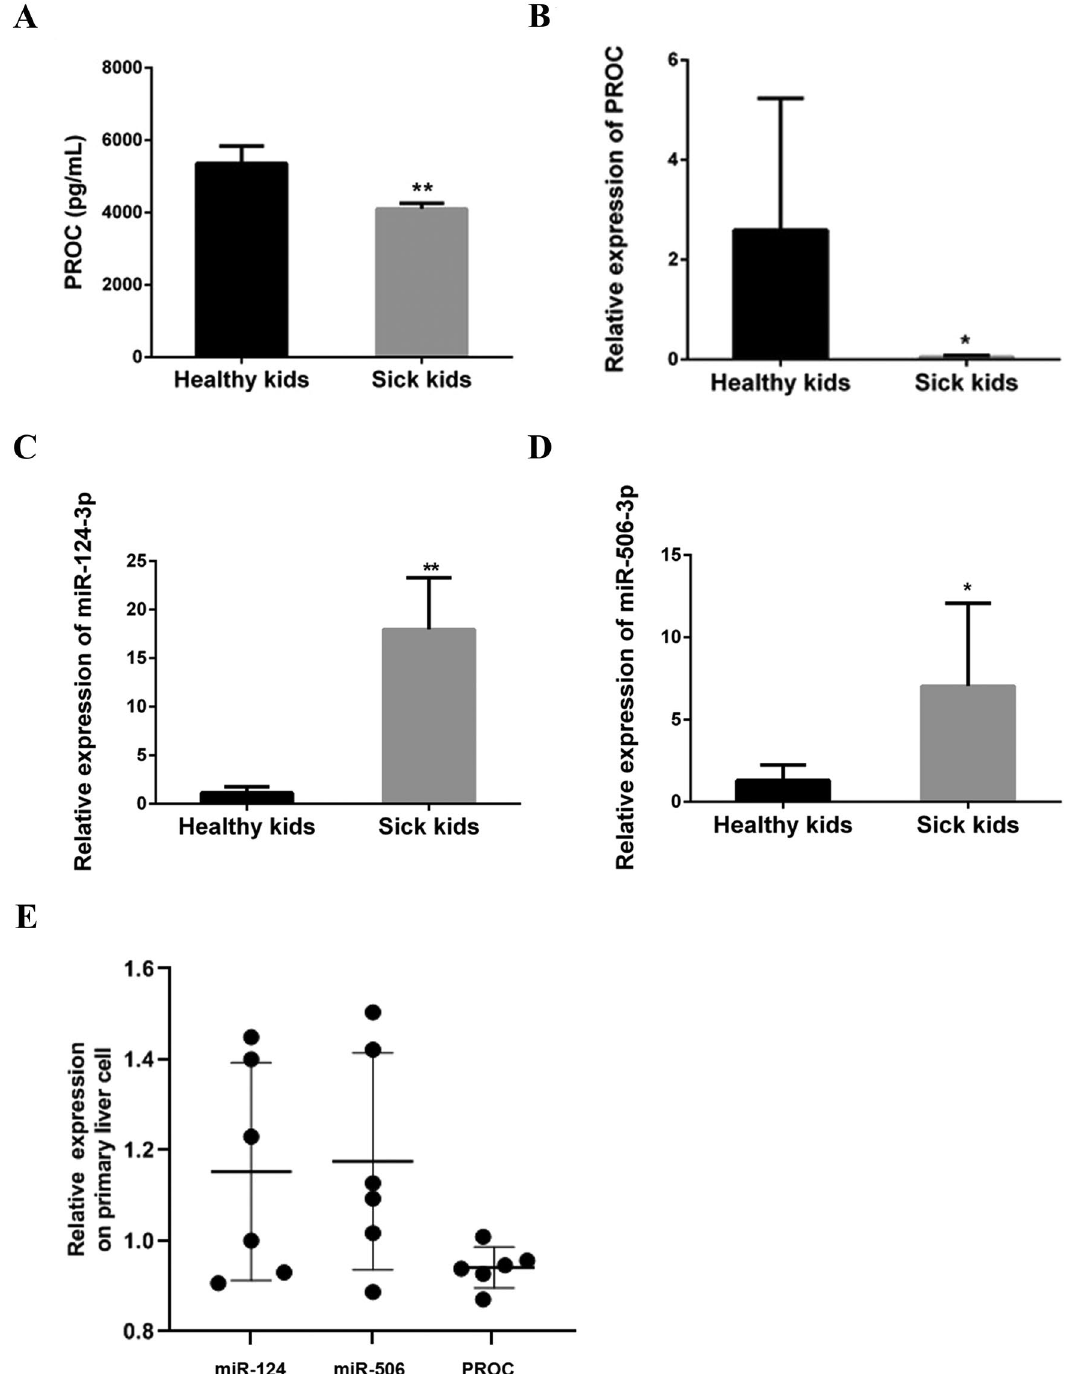
Figure 1. Detection of PROC and miRNAs. The protein and transcriptional levels of PROC was detected by ELISA ( A ) and qRT-PCR ( B ) in healthy kids and sick kids. The expressions of miR-124-3p ( C ) and miR-506-3p ( D ) were detected by qRT-PCR in healthy kids and sick kids. Healthy kids means whole blood samples of normal children. Sick kids means whole blood samples of children with EHPVO after Rex shunt. ( E ) Primary liver cells were harvested from mice live, and mRNA levels of PROC, miR-506 and miR-124 were determined by qRT-PCR in the primary liver cells. **Represents P < 0.01, *represents P <